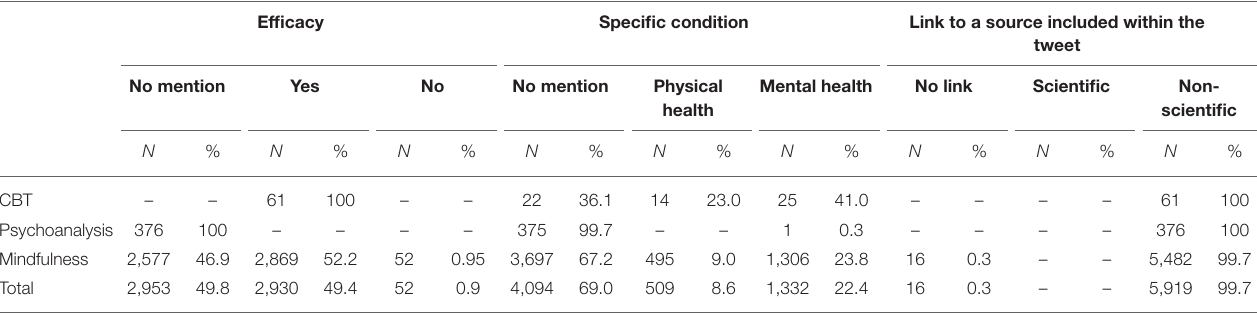
TABLE 2 | Number of tweets posted from 2009 to 2019 by 25 major US media outlets and retweets generated by their followers about psychotherapies according to different characteristics. Efficacy